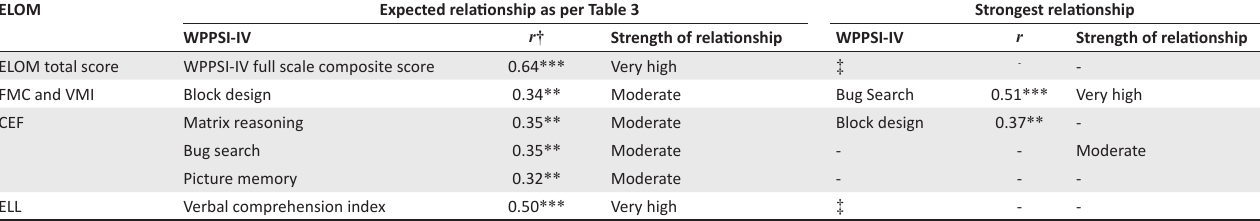
TABLE 8: Expected versus strongest relationships of Early Learning Outcomes Measure domains with WPPSI-IV subtests.